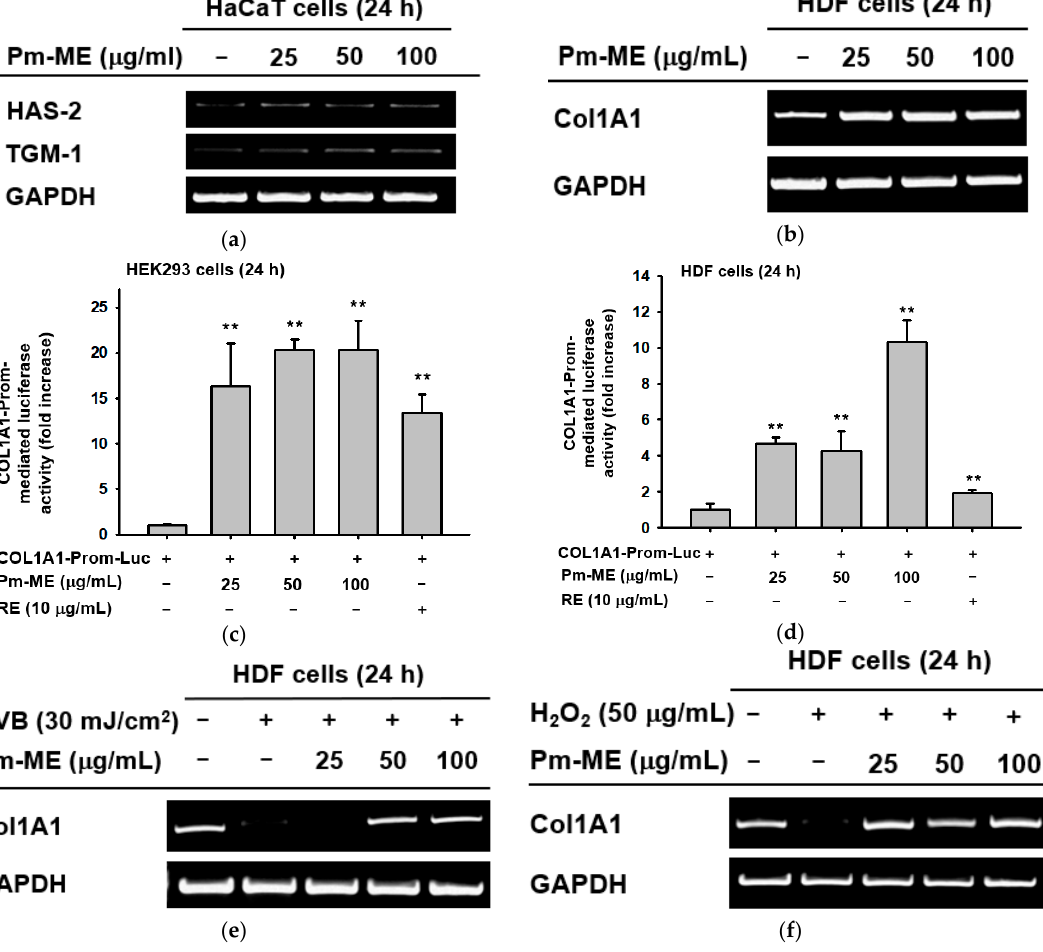
Figure 3. Moisturizing and collagen-increasing effects of Pm-ME in HaCaT and HDF cells. ( a , b , e , f ) Expression levels of moisturizing-related genes ( HAS-2 , and TGM-1 ) in HaCaT cells ( a ) and Col1A1 in HDF cells ( b ) treated with Pm-ME (0–100 µ g/mL) for 24 h, or Col1A1 in HDF cells exposed to UVB radiation (30 mJ/cm2) ( e ) or H 2 O 2 (50 µ g/mL) ( f ) in the presence or absence of Pm-ME (0–100 µ g/mL) for 24 h were determined by RT-PCR. ( c , d ) Col1A1 -promoter-derived luciferase activity from both HEK293 ( c ) and HDF ( d ) cells transfected with Col1A1 -Luc in the presence or absence of Pm- ME (0–100 µ g/mL) was determined by luminometer. ** p < 0.01 versus a control group (induced